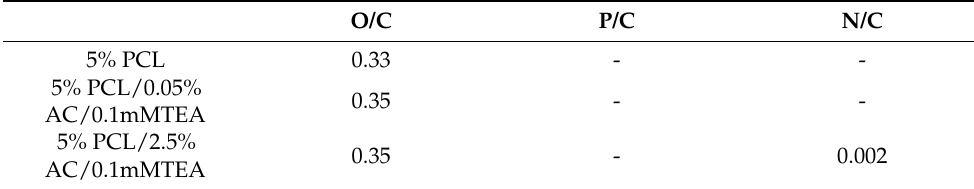
Table 5. Composition of elements in surface and near-surface layers of fibers according to XPS.